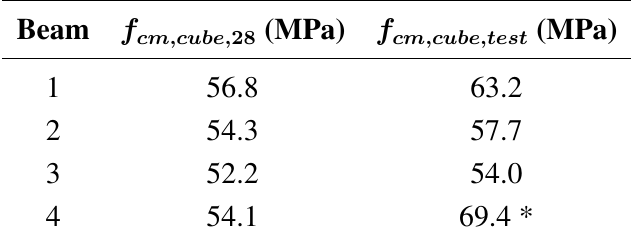
Table 2. Average concrete compressive strength after 28 days, f day, f (* estimated according to fib -bulletin 1 cm,cube,test